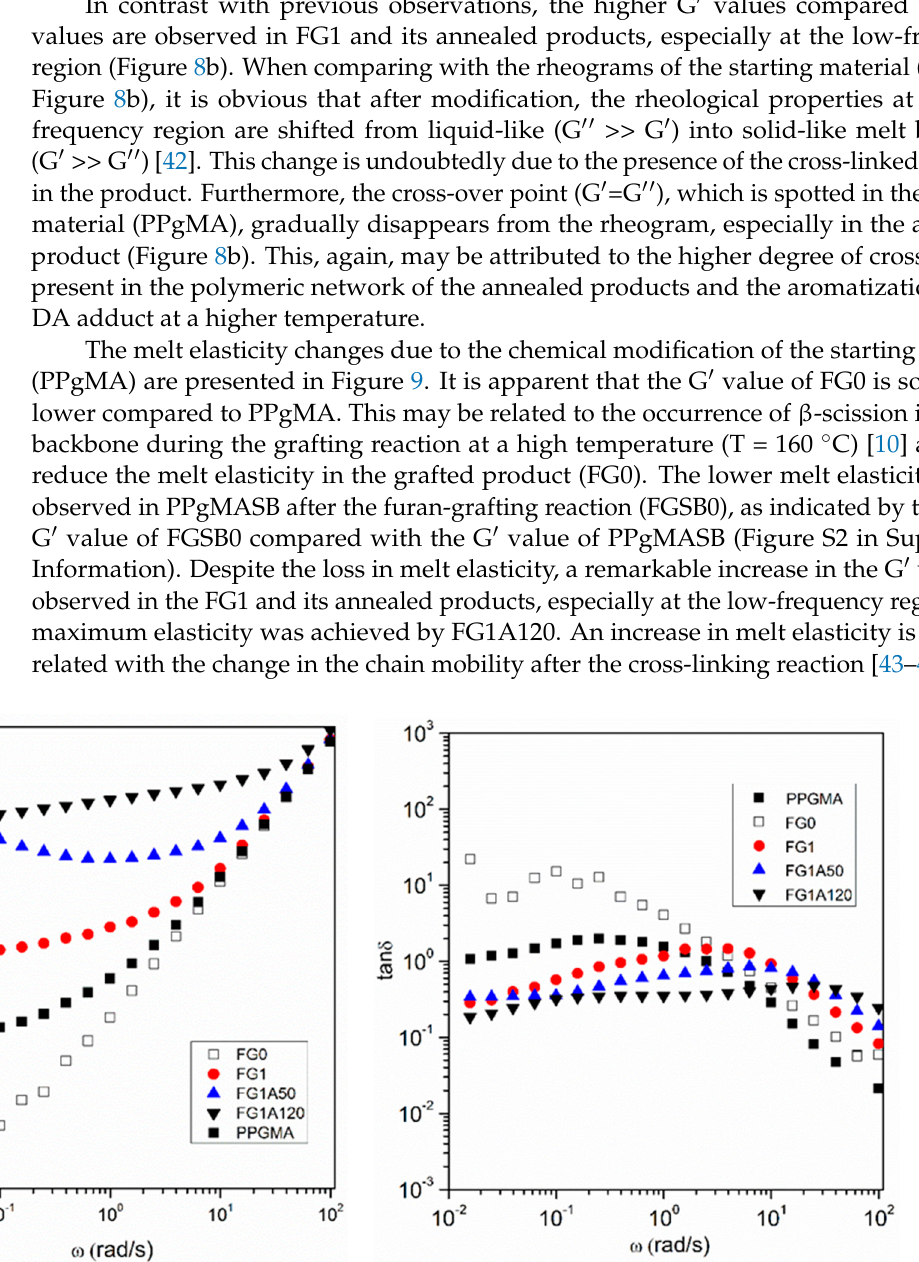
Figure 8. Storage (G’) and loss (G”) modulus of PPgMASB and its derivatives (FGSB1, FGSB1A50, FGSB1A120) ( a ); PPgMA and its derivatives (FG1, FG1A50, FG1A120) ( b ) at various angular fre- quencies ( ω , rad/s) measured at 160 °C.